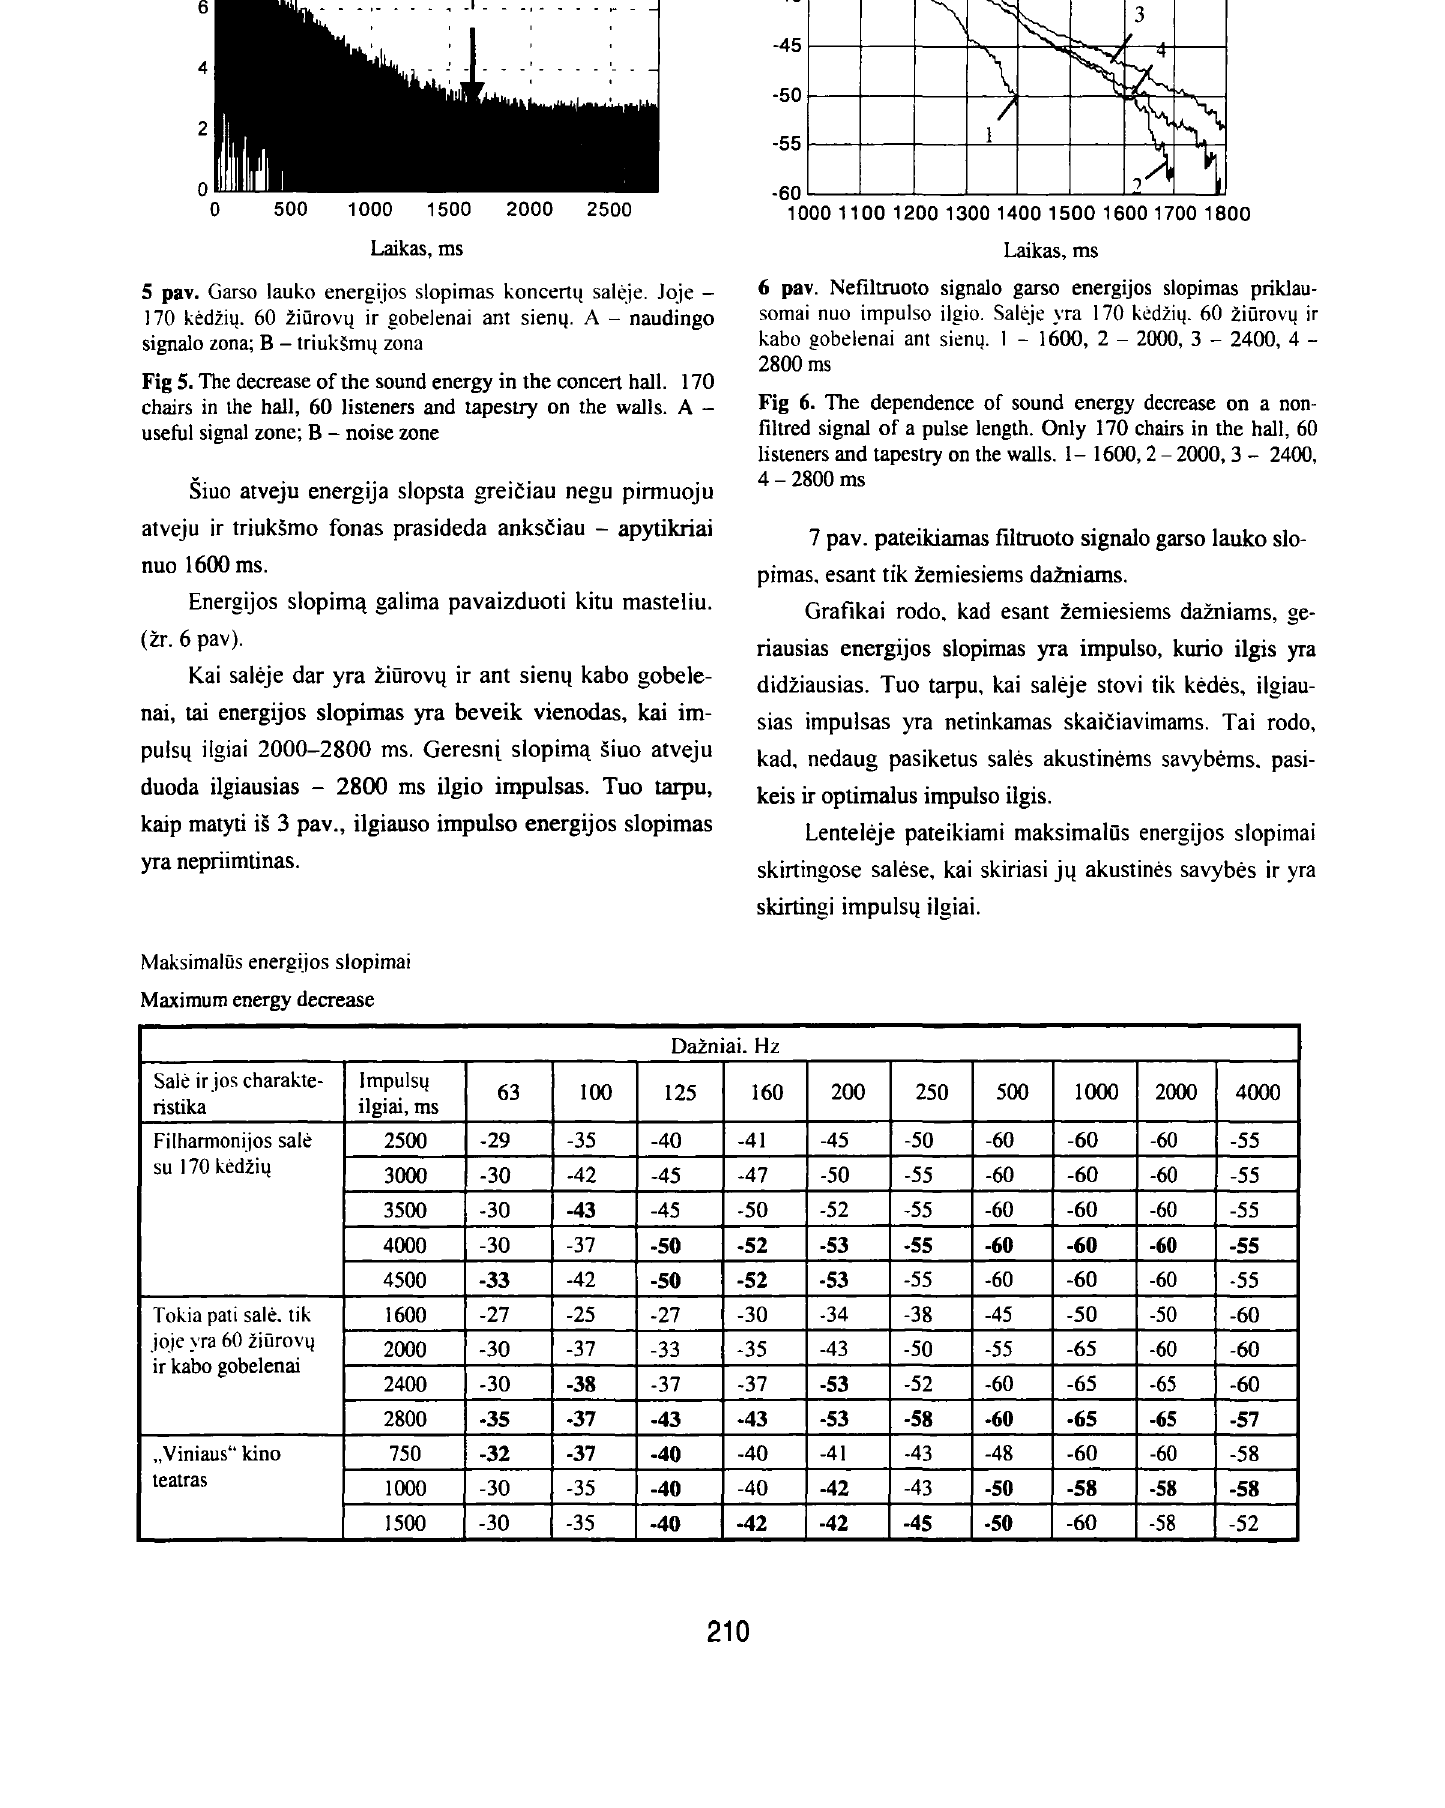
5 pav. Garso lauko energijos slopimas koncert4 saleje. Joje - 1 70 ked.Zi4. 60 ziiirovq ir gobelenai ant sien4. A - naudingo signalo zona; B - triuksmq zona Fig 5. The decrease of the sound energy in the concert hall. 1 70 chairs in the hall, 60 listeners and tapestry on the walls. A - useful signal zone; B - noise zone Siuo atveju energija slopsta greiciau negu pinnuoju atveju ir triuksmo fonas prasideda anksciau - apytikriai nuo 1600 ms. Energijos slopim'l galima pavaizduoti kitu masteliu. (zr. 6 pav).